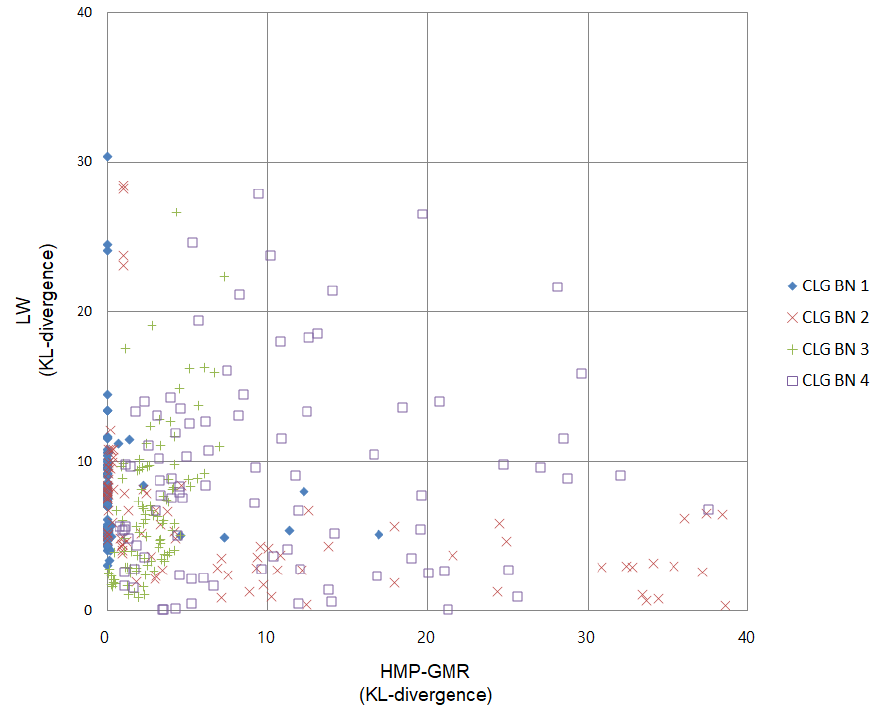
Figure 10. Accuracy comparison between LW and HMP-GMR for four CLG